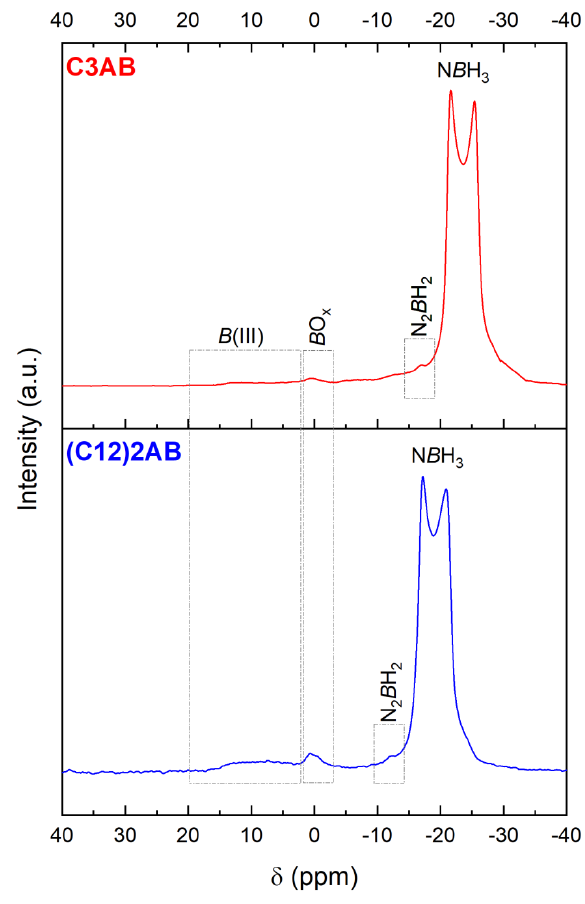
Figure 7. 11 B MAS NMR of the ABAs in solid state, i.e., of C3AB and (C12)2AB. The signals are assigned, and discussed in the main text.